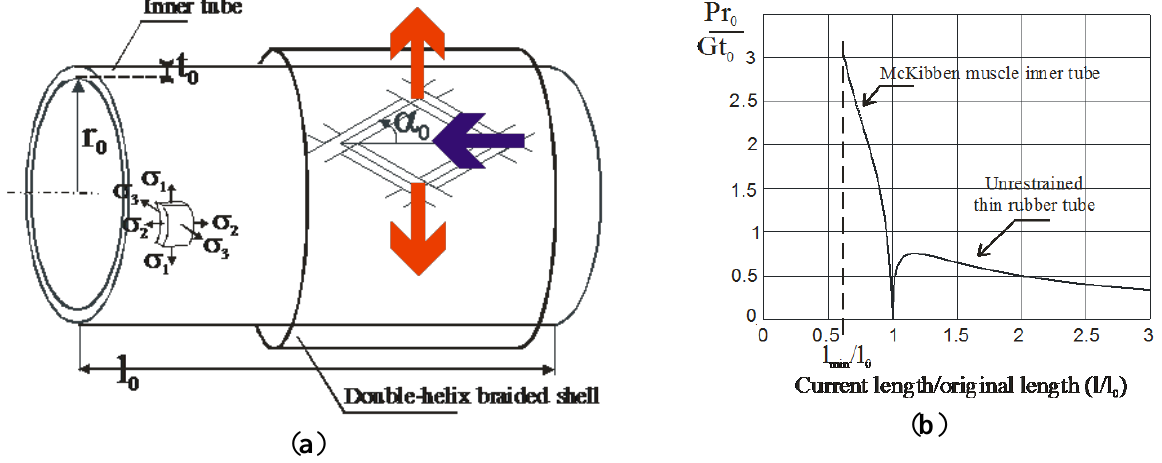
Figure 2. Interpretation of the braided sleeve movement of the McKibben artificial muscle as the internal process giving to the actuator its artificial muscle nature; ( a ) combination of the pressurized inner tube and the braided sleeve inside the McKibben structure; and ( b ) a comparison between the static behavior of an unrestrained thin rubber tube becoming unstable beyond the ballooning pressure and the stable behavior of the McKibben muscle inner tube (see